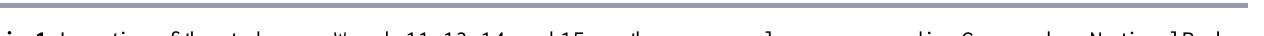
Fig. 1. Location of the study area. Wards 11, 13, 14, and 15 are the communal areas surrounding Gonarezhou National Park and Gonakudzingwa small-scale commercial farms in southeastern Zimbabwe. Representative members who identified livelihood types and constructed corresponding fuzzy cognitive maps reside in the communal areas shown. Wards overlap with ward names given in the